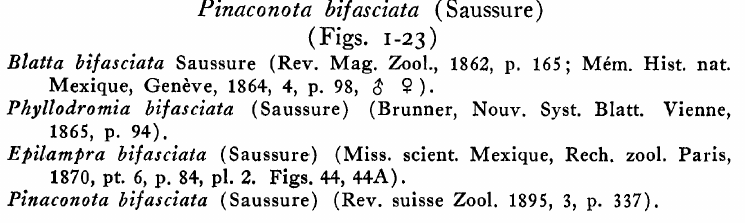
(Figs. 1-23) Blatta biJasciata Saussure (Rev. Mag. Zool., 1862, p. 165; Mm. Hist.